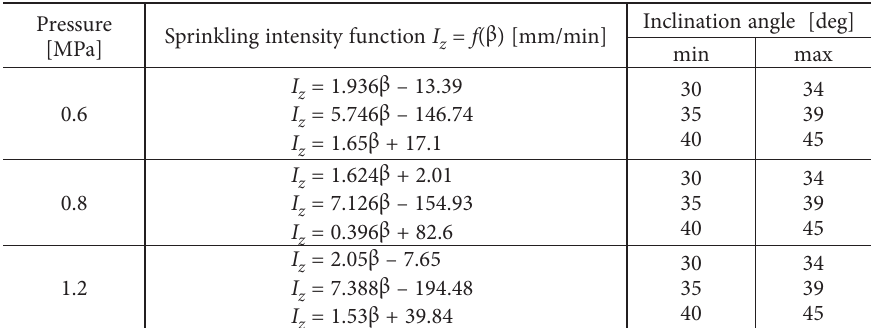
Table 2. A set of sprinkling intensity functions I z = f (β) for solid jet obtained as a result of approximation